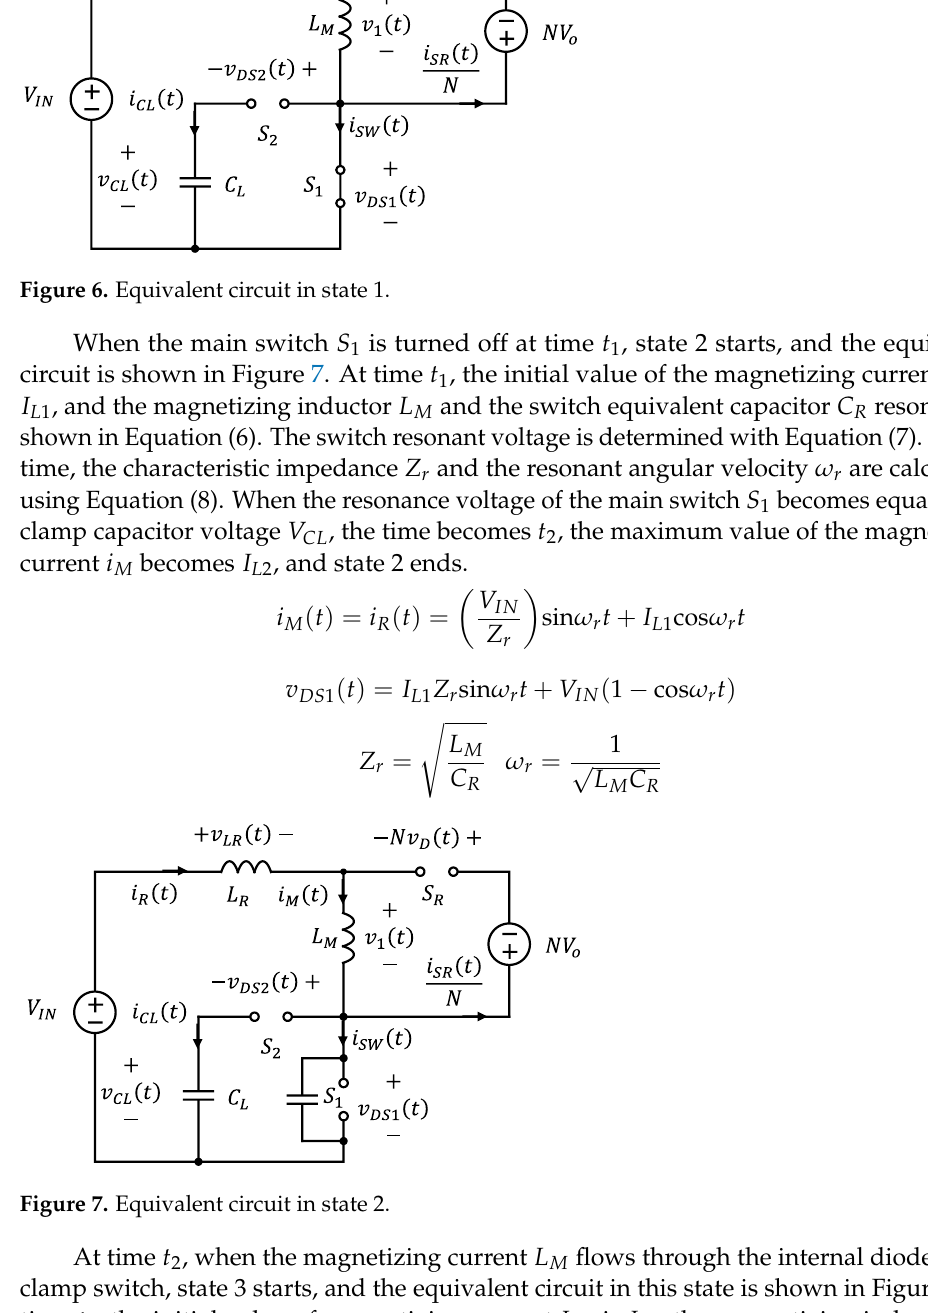
Figure 8. Equivalent circuit in state 3. 𝑖 𝐶𝐿 (𝑡) = 𝑖 𝑀 (𝑡) = 𝑖 𝑅 (𝑡) = (𝑉 𝐼𝑁 − 𝑉 𝐶2 𝑍 𝑅